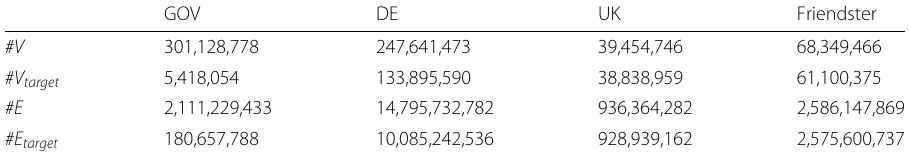
Table 1 Statistics on the studied real-world graphs, see “Seed selection and crawling” and “Real-world graphs” sections for details (# V : original number of vertices, # E : original number of edges, # V target : target number of vertices, # E target : target number of edges) GOV